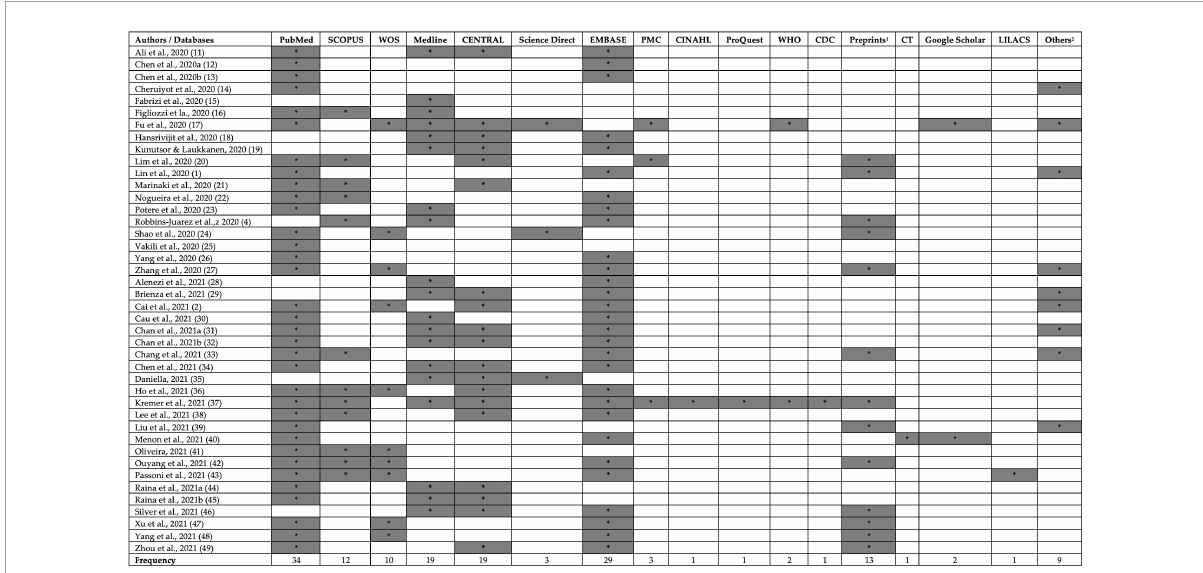
FIGURE2 Search databases used in included reviews. CDC, Centers for Disease Control and Prevention database; CENTRAL, Cochrane Central Register of Controlled Trials; CINAHL, Cumulated Index to Nursing and Allied Health Literature; CT, ClinicalTrials.gov; PMC, PubMed Central; WHO, world health organization database; WOS, Web of Science. 1 Preprints: BioRvix, MedRvix, and 2 Other databases: Chinese databases, Intensive Care National Audit and Research Center (ICNARC) website, DARE database, CNKI, VIP, WanFang. The symbol * represents the presence